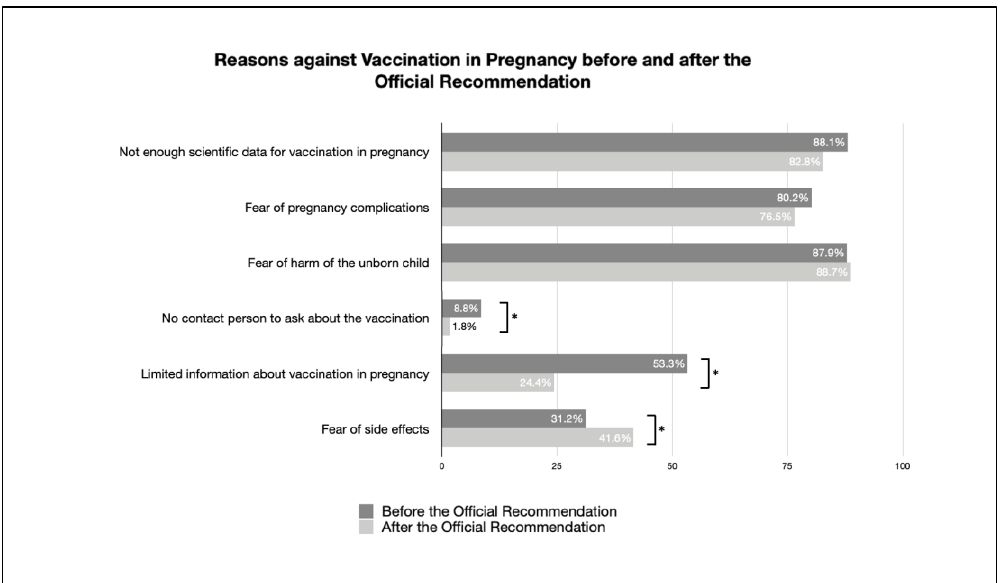
Figure 4. Reasons against vaccination in pregnancy (percentage of reasons given by participants against being vaccinated; multiple answers possible; * indicates a significant difference).